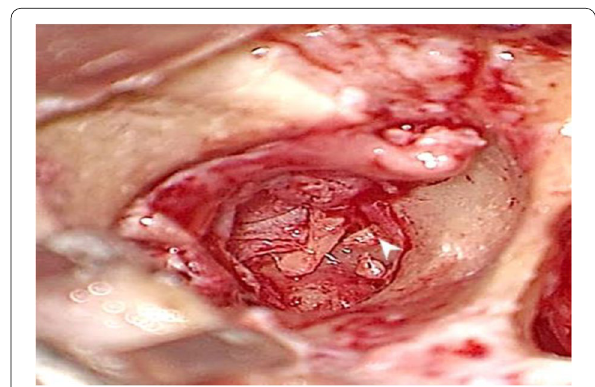
Fig. 1 Erosion of long process of the incus